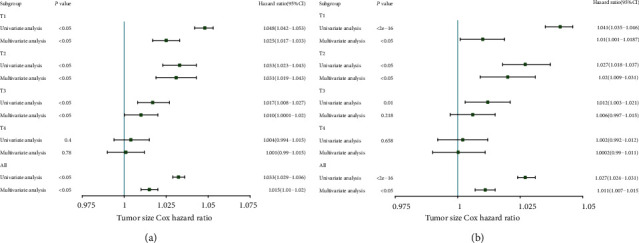
The hazard ratio (HR) of tumor size in predicting survival on esophageal cancer based on the different T stages: (a) CSS set and (b) OS set.